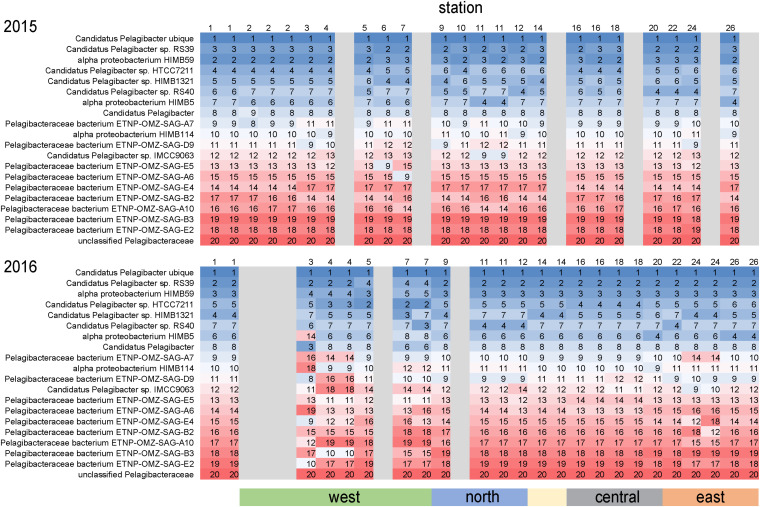
Differential metagenome read recruitment to SAR11 clade reference bins across the archipelago. For each sampling station, the rank order of 20 SAR11 clade reference bins available in NCBI RefSeq v84 is shown in each column and colored from top recruiting (blue) to lowest recruiting (red). Grayed columns indicate no metagenomes were acquired at the site that year.